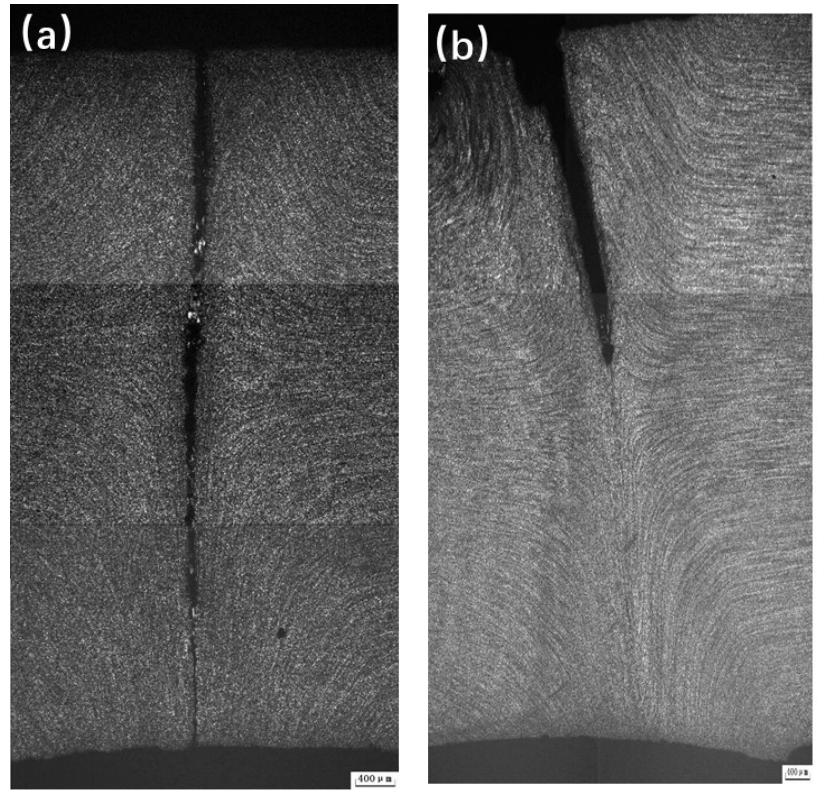
Figure 12. Streamline morphology of cracking pipe ( a ) 1#; ( b ) 2# .